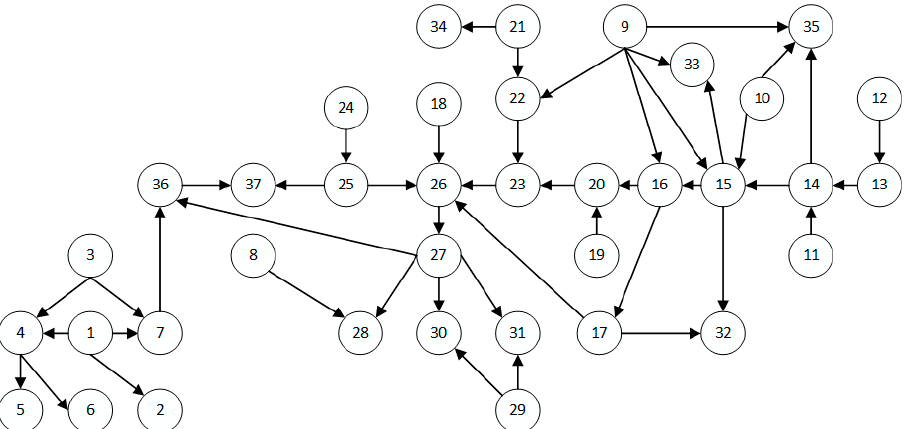
Figure 5. ASIA after learning.